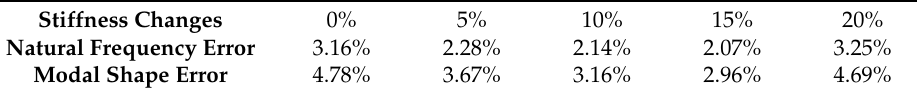
Table 4. Identification error of simulated suspension spring faults.